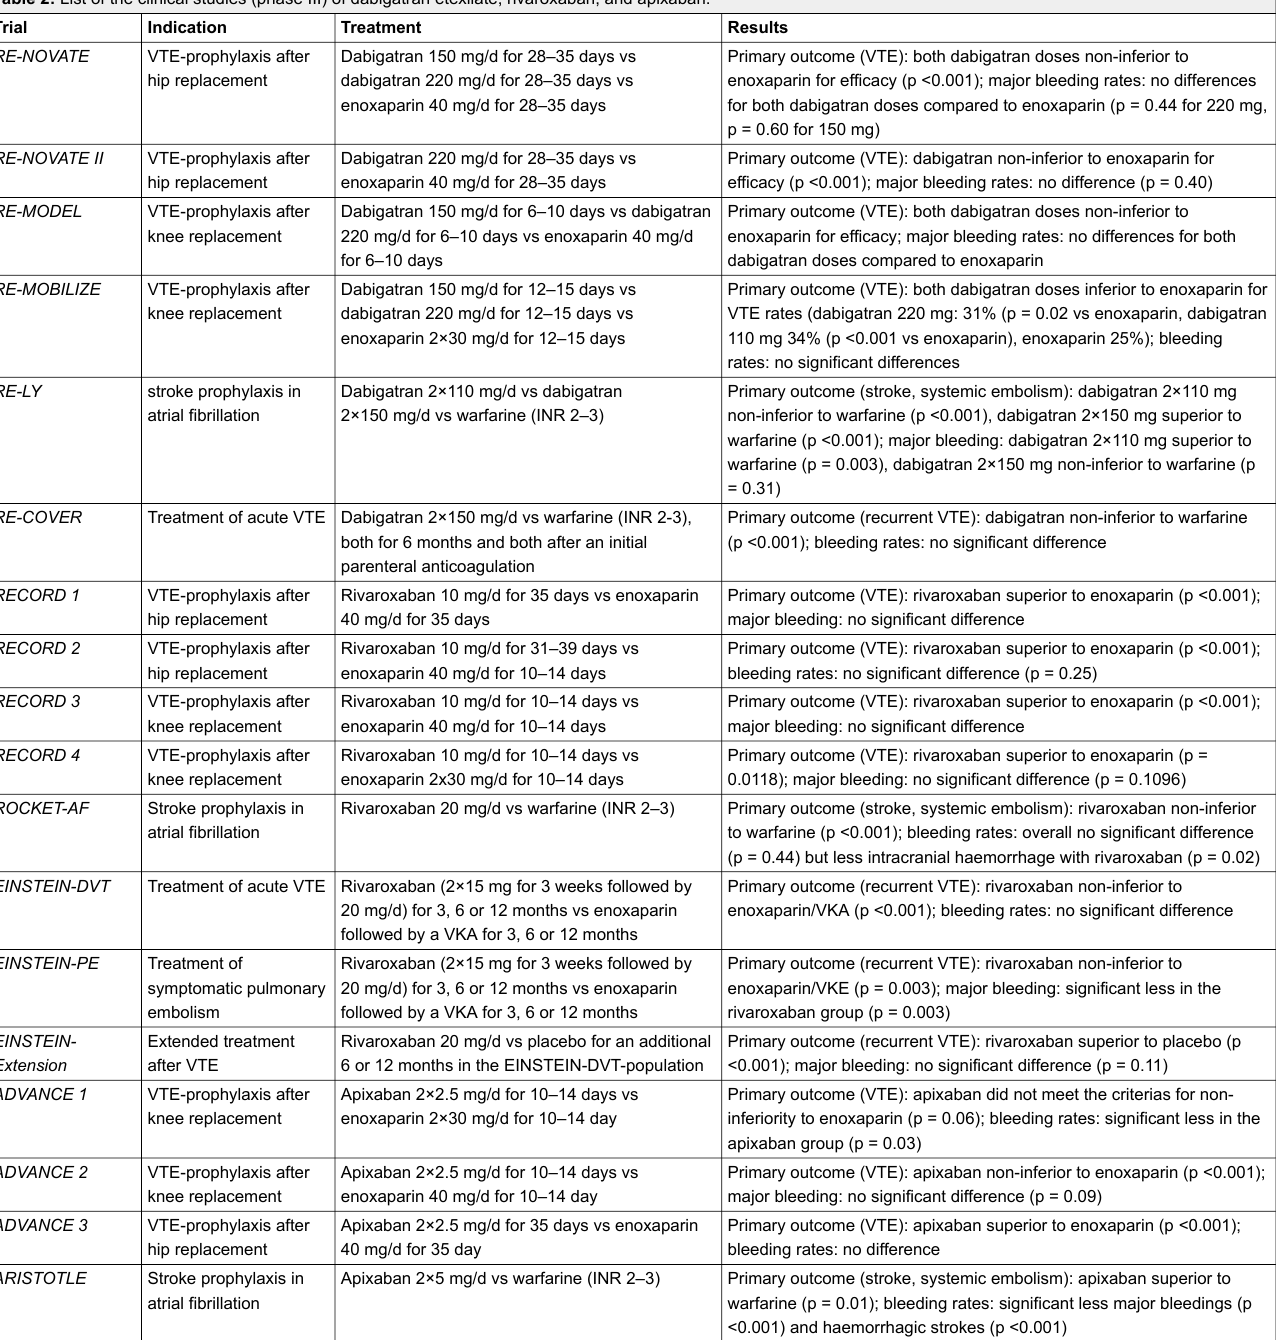
Table 2: List of the clinical studies (phase III) of dabigatran etexilate, rivaroxaban, and